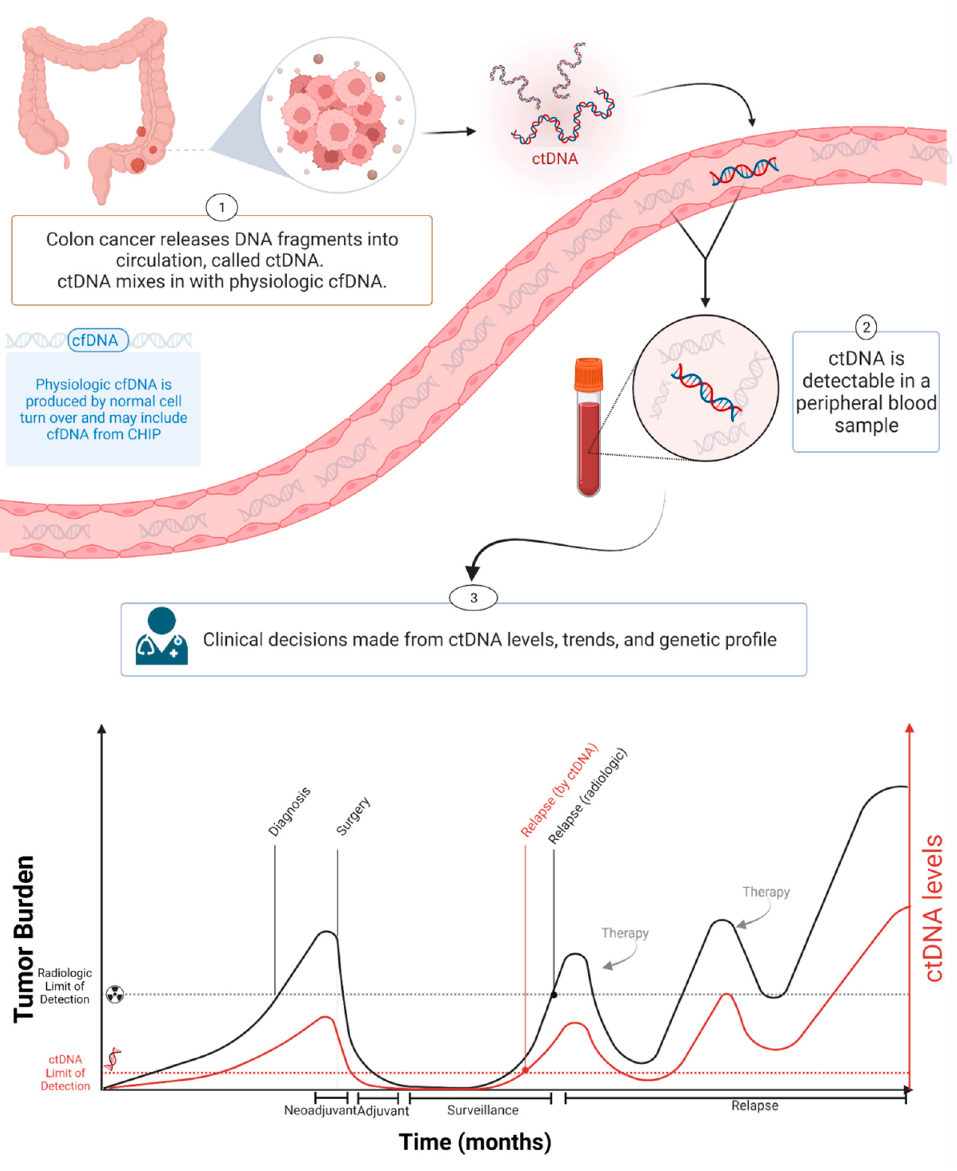
Figure 1. ctDNA during cancer progression. Created with BioRender.com.